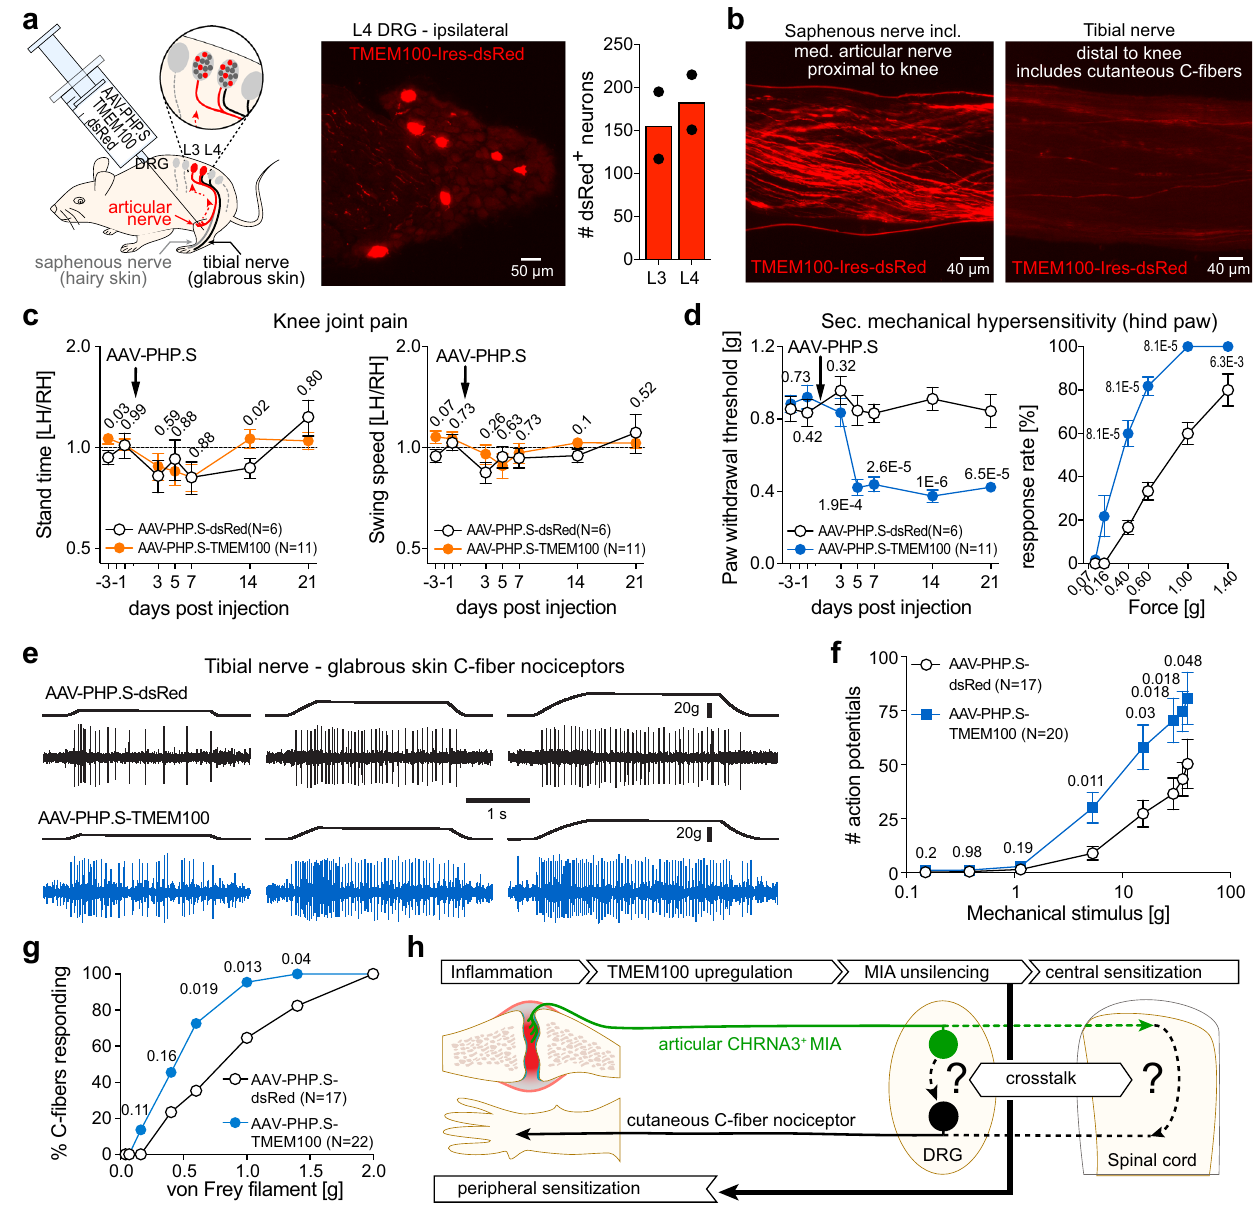
Fig. 7 | Overexpression of TMEM100 in articular afferents induces secondary mechanical hypersensitivity in the hind paw but no knee joint pain. a Cartoon depicting the experimental approach (left), image of a DRG section from a mouse that had received intraarticular AAV-PHP.S-TMEM100-Ires-dsRed (middle) and quanti fi cation of the mean±SEM number of dsRed + neurons (right) in L3 and L4 DRGs from two mice. b dsRed fl uorescence in the tibial nerve distal to the knee (right) and the saphenous (left) nerve proximal to the knee which contains the medial articular nerve. c Comparison of the mean±SEM stand time (left) and leg swingspeedratios(right)ofWTmiceattheindicatedtimepointsafteri.a.injection of AAV-PHP.S-dsRed control virus (white circles) and AAV-PHP-S-TMEM100-Ires- dsRed (orange circles). Ratios were compared using multiple two-sided Mann- Whitneytests( P -valuesandN-numbersareprovidednexttothesymbolsandinthe graph legend). d Comparison of the mean±SEM mechanical paw withdrawal thresholds (left) and the response rates at 14 dpi (right, % paw withdrawals in response to fi ve successive stimulations with the indicated von Frey fi laments) of